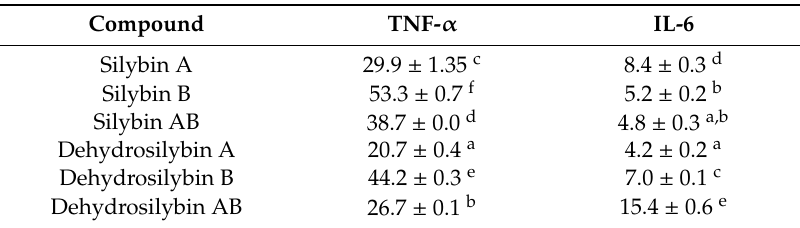
Figure 5. Effect of silybin diastereomers ( a ) and dehydrosilybin enantiomers ( b ) on relative production of TNF- α by LPS-stimulated RAW 265.4 macrophages. Data represent the average of four repetitions with corresponding standard error of the mean. Table 3. Inhibition of the release of pro-inflammatory cytokines TNF- α and IL-6 by silybin and dehydrosilybin stereomers.